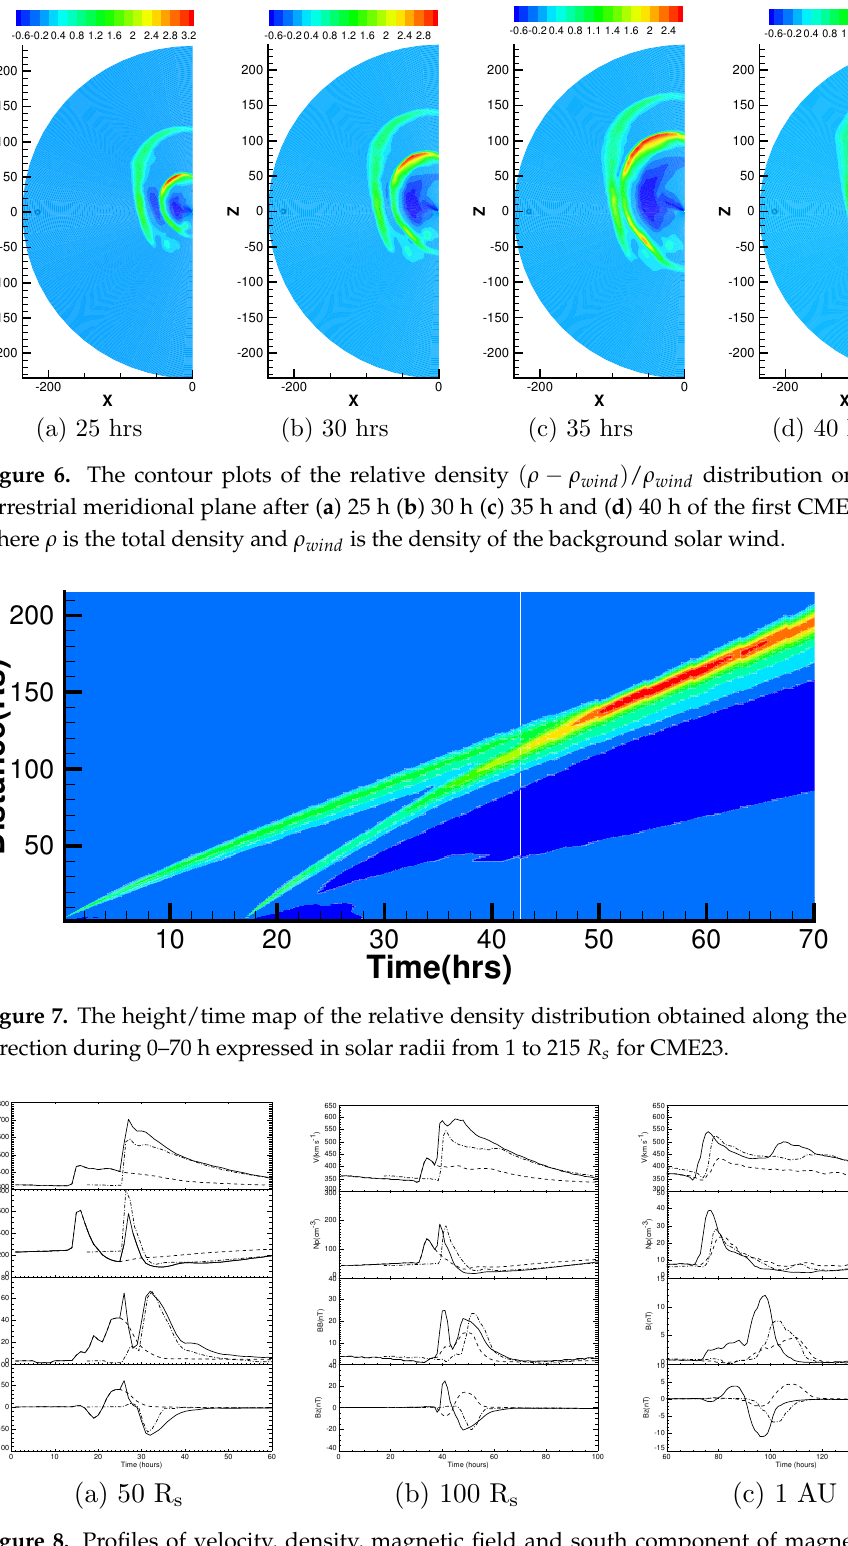
Figure 8. Profiles of velocity, density, magnetic field and south component of magnetic field as function of time at different heliospheric distances: ( a ) 50 R s ( b ) 100 R s and ( c ) 1 AU for CME2 (dashed line), CME3 (dash-dotted line) and CME23 (solid